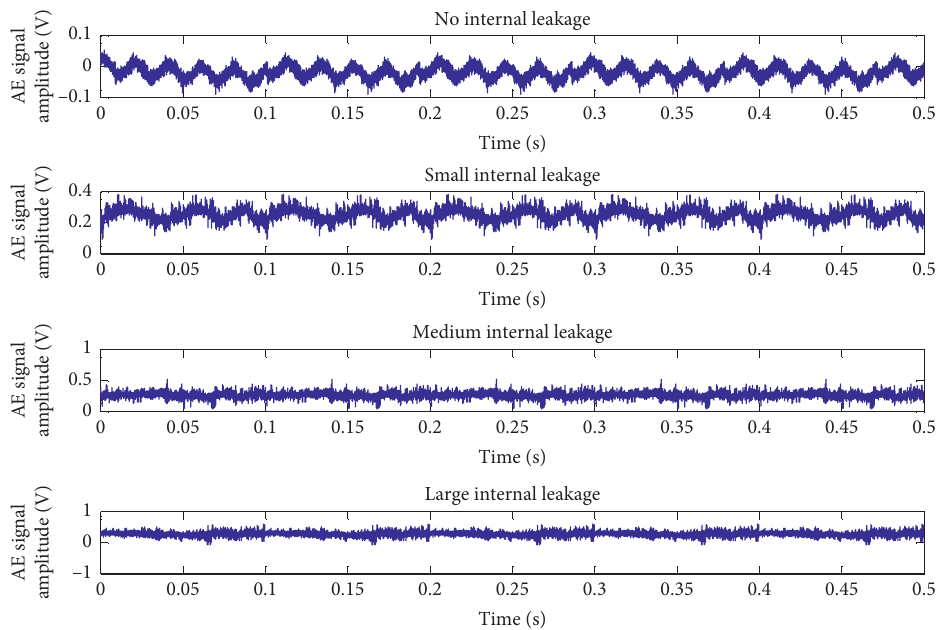
Figure 5: AE signals under a load of 1MPa in four different internal leakage states.